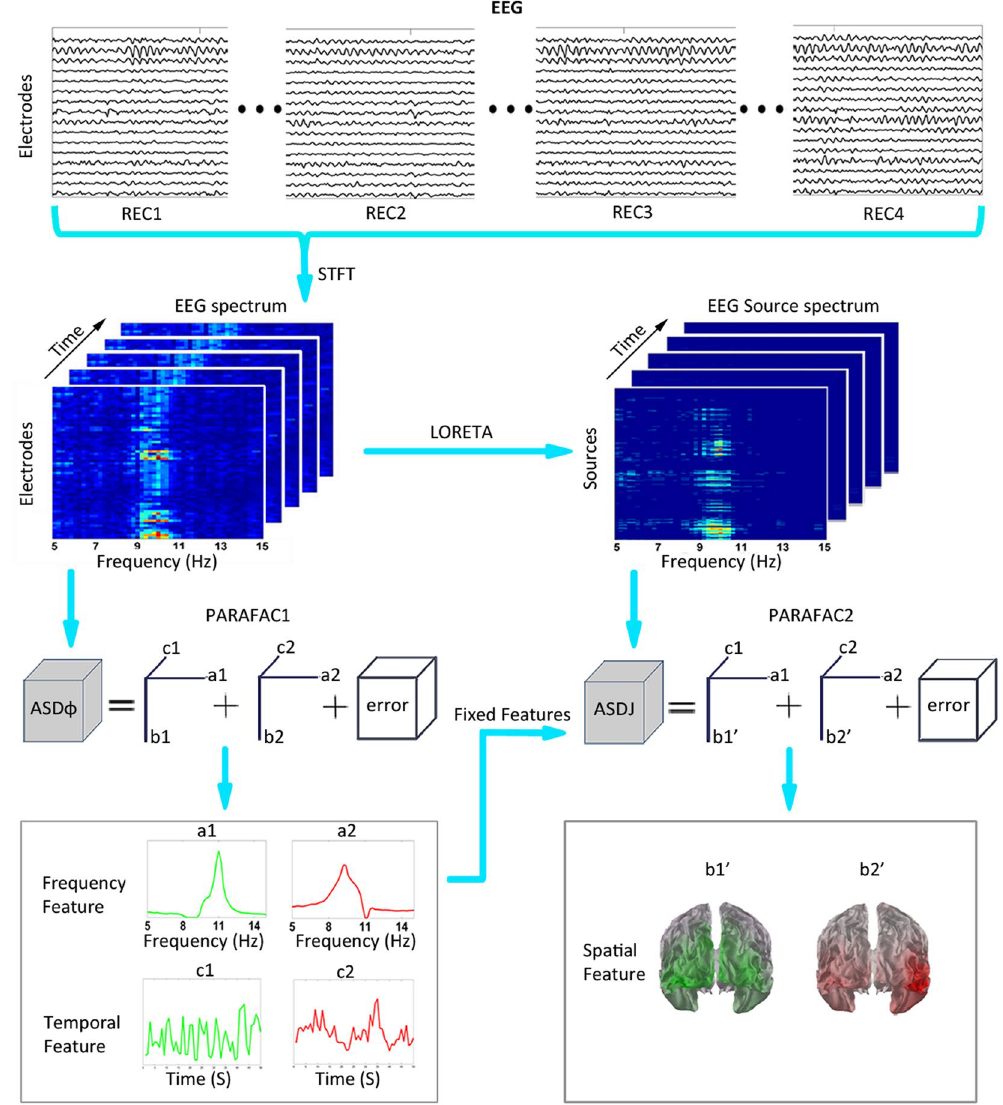
Figure 1. Extraction of alpha rhythm components (ARCs) from EEG signal. The top row shows 4 EEG segments from corresponding REC periods in a single subject. To extract the time-varying EEG power spectrum matrix, Short-Time Fourier Transformation (STFT) was applied to these concatenated EEG time series. Next, the obtained 3-way amplitude spectrum matrix was used as an input for PARAFAC1 to extract the frequency and temporal features of the ARCs. This figure shows a PARAFAC model with two components, where a1 and a2 refer to the frequency features, c1 and c2 indicate temporal features (left bottom panel), and b1 and b2 represent the spatial features of the ARCs in the electrode space (b1 and b2 are not shown, since they were not used for further analysis). To extract the sources of each ARC (b1’ and b2’, right bottom panel), the EEG source spectrum was calculated with the LORETA method. Then, PARAFAC2 was applied to the source amplitude spectrum using fixed frequency (a1, a2) and temporal (c1, c2) features obtained in the sensor-space PARAFAC1. See Methods for